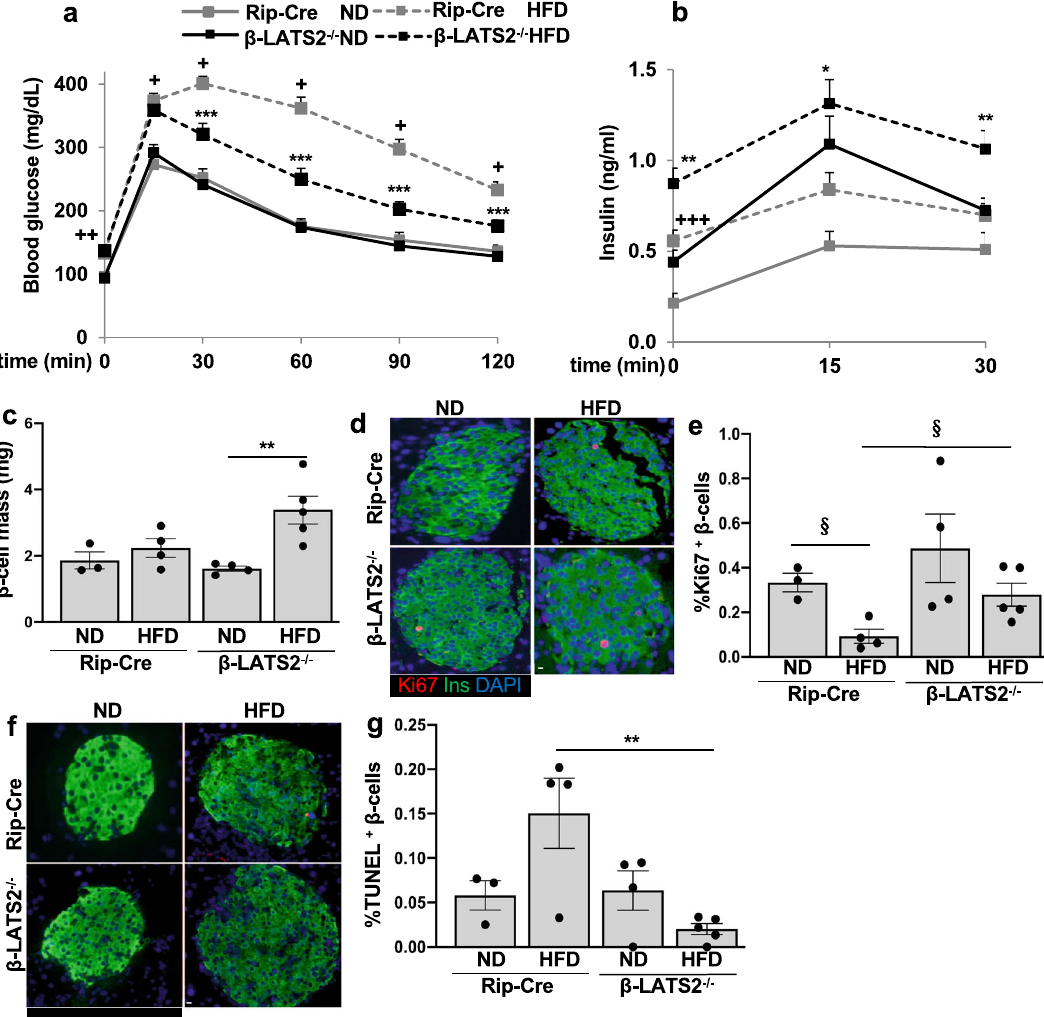
Fig. 6 β -cell speci fi c LATS2 ablation protects from HFD induced diabetes in vivo. a – g β -LATS2 − / − and Rip-Cre control mice were fed a normal (ND) or high fat/ high sucrose diet ( “ Surwit ” ; HFD) for 17 weeks. a intraperitoneal glucose tolerance test (ipGTT) (Rip-Cre ND n = 8; Rip-Cre HFD n = 21; β -LATS2 − / − ND n = 10; β -LATS2 − / − HFD n = 19). b Insulin secretion during an ipGTT measured before (0min), 15 and 30min after glucose injection (Rip-Cre ND n = 7; Rip-Cre HFD n = 18; β -LATS2 − / − ND n = 10; β -LATS2 − / − HFD n = 15). c – g Mice were sacri fi ced at week 17. c β -cell mass given as percentage of the whole pancreatic section from 10 sections spanning the width of the pancreas (Rip-Cre ND n = 3; Rip-Cre HFD n = 4; β -LATS2 − / − ND n = 4; β -LATS2 − / − HFD n = 5). Representative images and quantitative analyses from triple staining for Ki67 ( d , e ) or TUNEL ( f , g ), insulin and DAPI expressed as percentage of TUNEL-